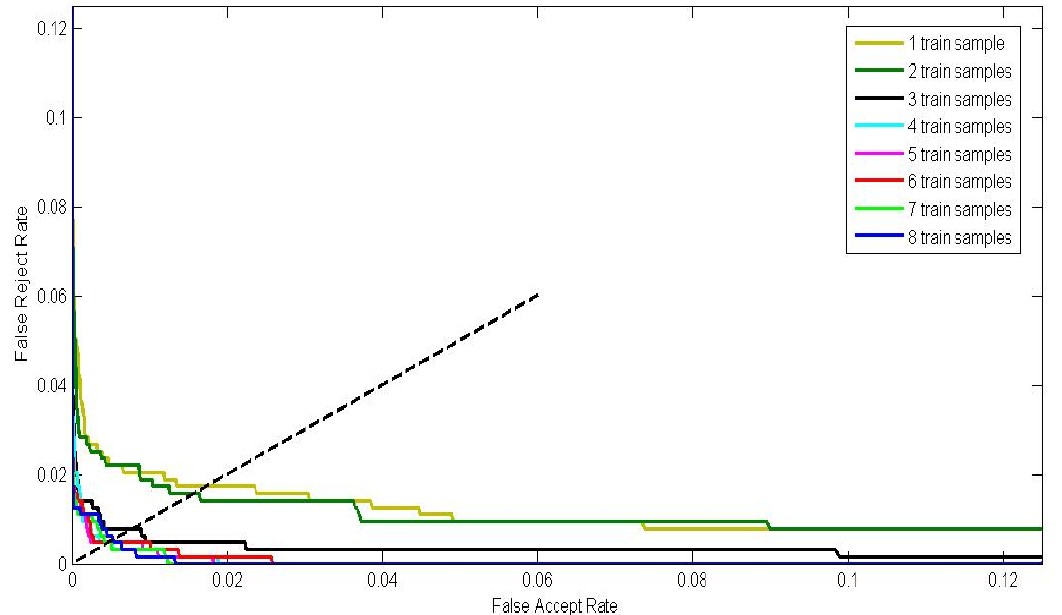
Figure 11. ROC curves by different number of training samples.